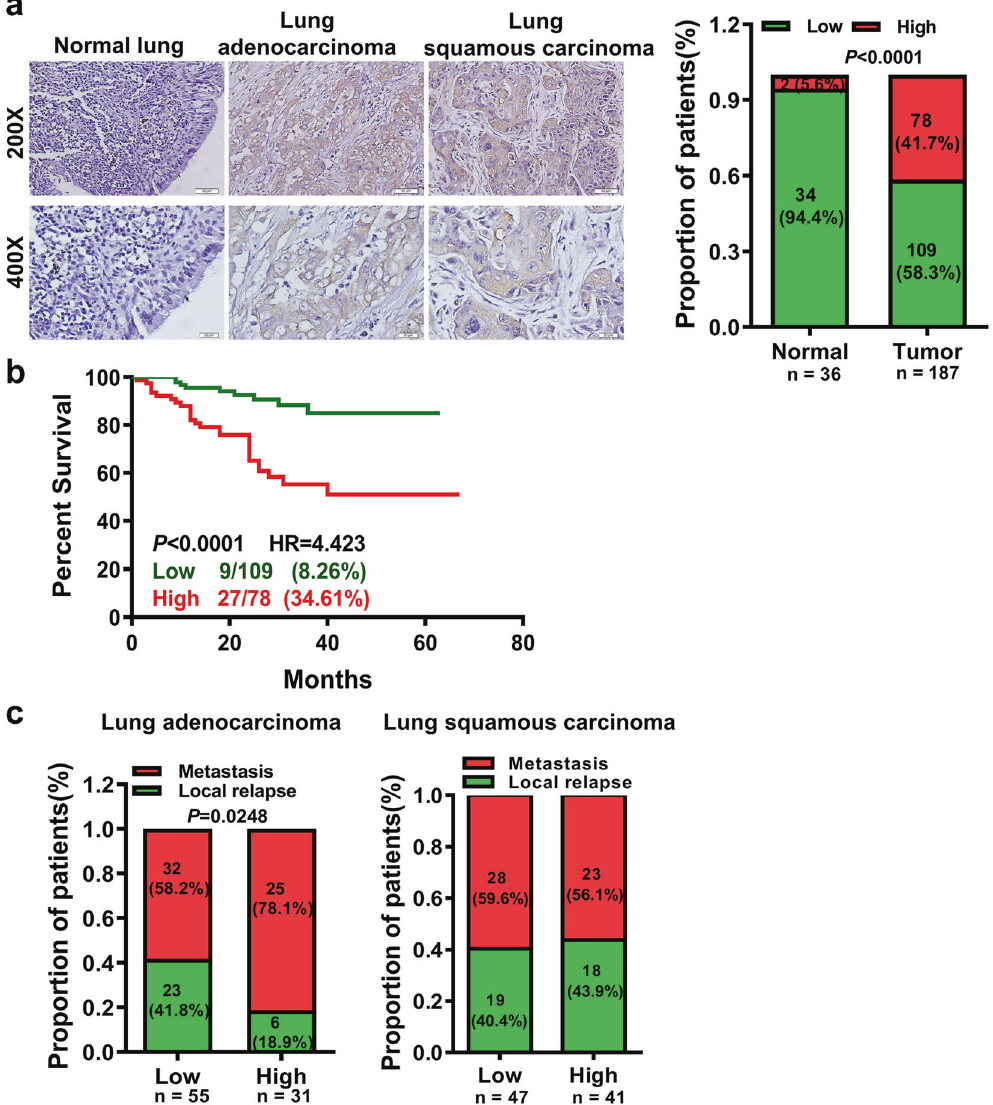
Fig. 1 The high expression of AFAP1-AS1 was positively associated with lung adenocarcinoma patients ’ poor prognosis. a AFAP1-AS1 was highly expressed in 187 lung cancer tissues (89 lung adenocarcinoma and 98 lung squamous carcinoma), comparing with 36 paraf fi n- embedded normal lung tissues as determined by in situ hybridization (left, representative pictures of in situ hybridization, Scale bar: 20 μ m or 50 μ m; right, the statistical results according to in situ hybridization score values; right, red: high expression, green: low expression). b The correlation between AFAP1-AS1 expression and prognosis of patients with lung cancer ( p < 0.0001, HR = 4.423) by Kaplan-Meier survival analysis. The prognosis of lung cancer patients with the high AFAP1-AS1 expression is signi fi cantly lower than that of lung cancer patients with the low AFAP1-AS1 expression. c High AFAP1-AS1 expression is positively correlated with distant metastasis in 86 patients with lung adenocarcinoma (left), but not in 88 patients with lung squamous carcinoma (right). Data are presented as the means ± SD Signal Transduction and Targeted Therapy (2021)